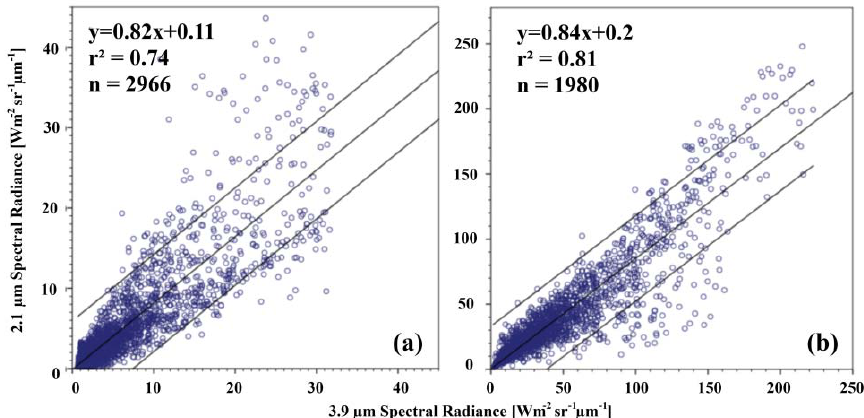
Figure 2. Linear best fit relationships between ‘excess above background’ SWIR (2.1 µ m) and MIR (3.9 µ m) spectral radiances recorded at active fire pixels in ( a ) real data extracted from the 50 m spatial resolution MODIS Airborne Simulator (MAS) imagery of cerrado fires burning in the northernmost MAS flight leg highlighted in Figure 1a, and ( b ) simulated observations of active fires made using the multiple thermal component model [3]. Whilst ( a ) contains some saturated observations when 3.9 µ m radiances become higher, ( b ) is unaffected by this and provides a very similar linear best fit relation.